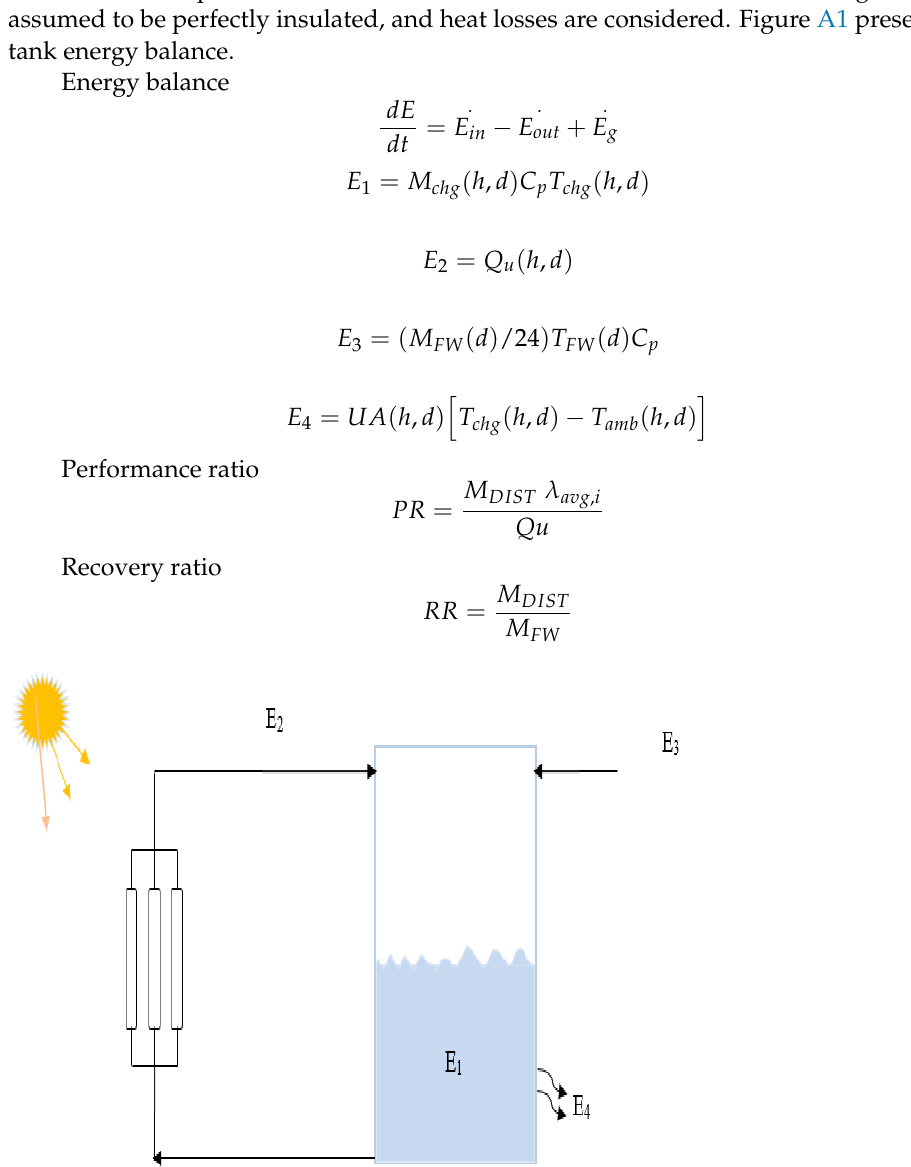
Figure A1. Energy balance of the storage tank.